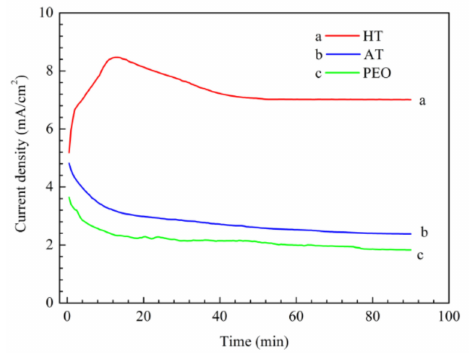
Figure 4. Current density– t curves recorded during the electrodeposition process of di ff erent pre-treated substrates in an aqueous mixed solution (0.0835 mol / L Ca(NO 3 ) 2 and 0.05 mol / L KH 2 PO 4 ). A DC voltage of 3.5 V was applied, while di ff erent pre-treatments ((a) HT, (b) AT, (c) PEO) were used as cathode and a graphite plate was used as